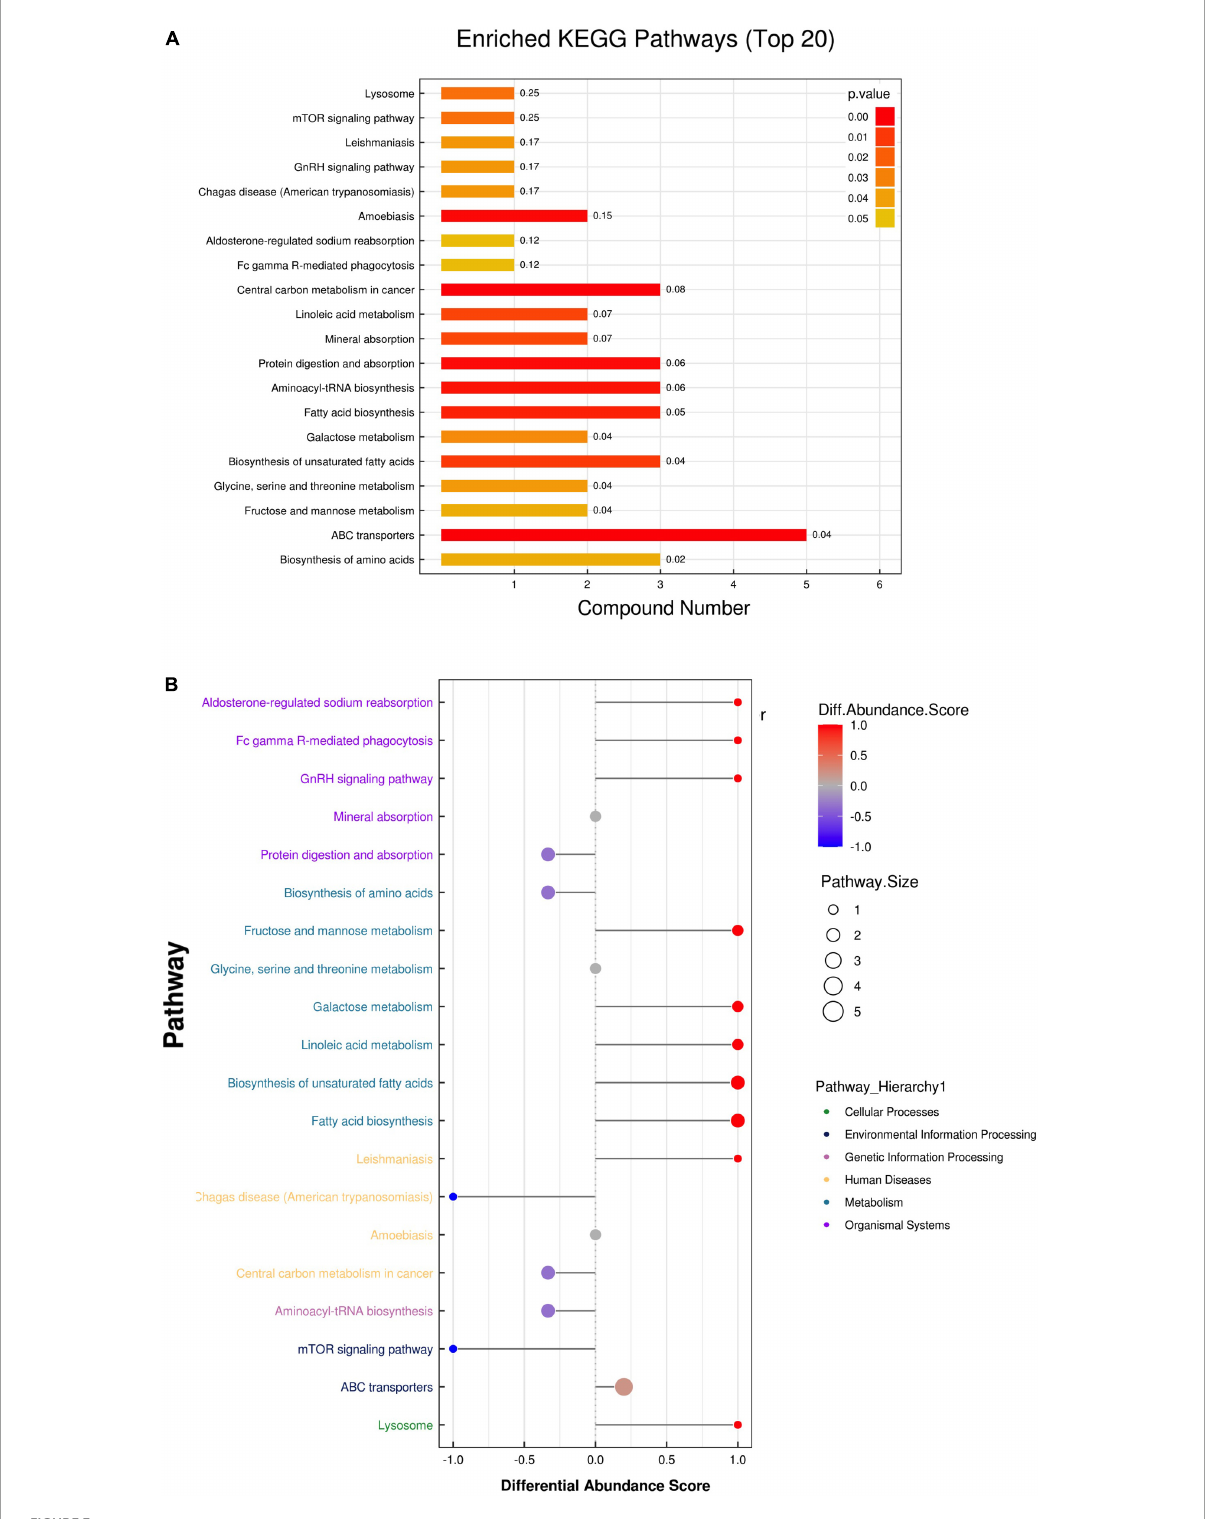
FIGURE3 Enrichment analysis of the metabolic pathway of the two groups. (A) The enrichment analysis of the Kyoto Encyclopedia of Genes and Genomes (KEGG) showed the overview pathway of different endogenous metabolites between HP and AD groups. (B) Differential abundance score map for all differential metabolic pathways analyzed by Pathway